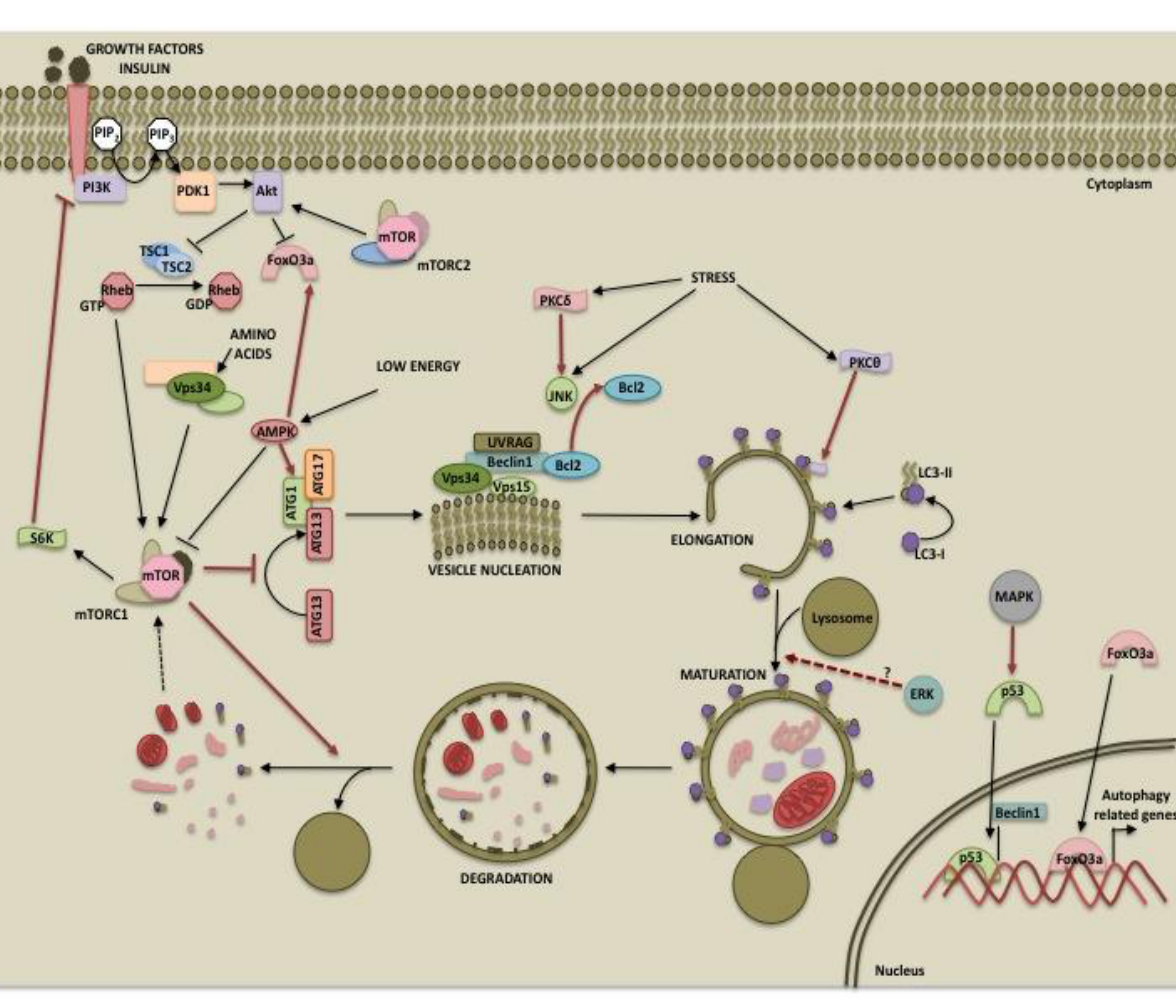
Figure 1. The regulation of autophagy by several cellular kinases. PI3K: phosphoinositide 3-kinases; PDK1: phosphoinositide-dependent kinase-1; mTOR: mammalian target of rapamycin; TSC: tuberous sclerosis complex; AMPK: AMP-dependent protein kinase; ERK: extracellular signal-regulated kinase; PKC: protein kinase